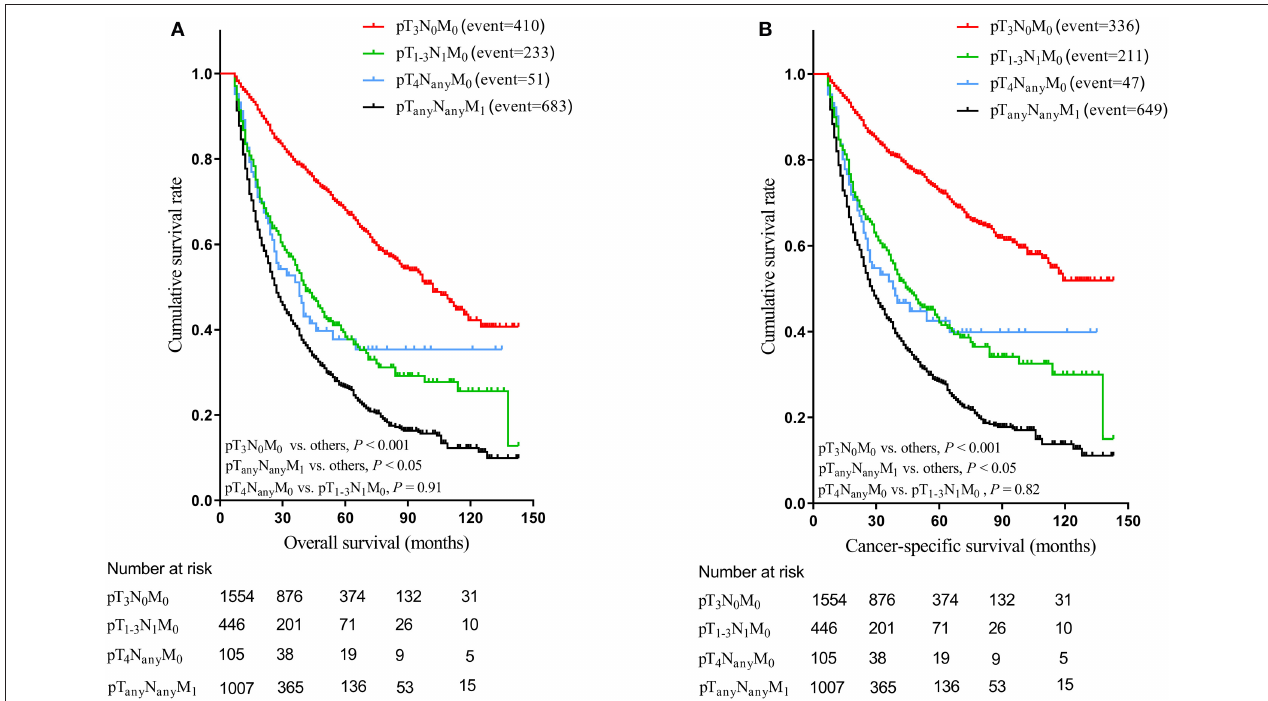
FIGURE 2 | Kaplan-Meier estimation of overall survival curves (A) and cancer-specific survival curves (B) relative to each group before matching.